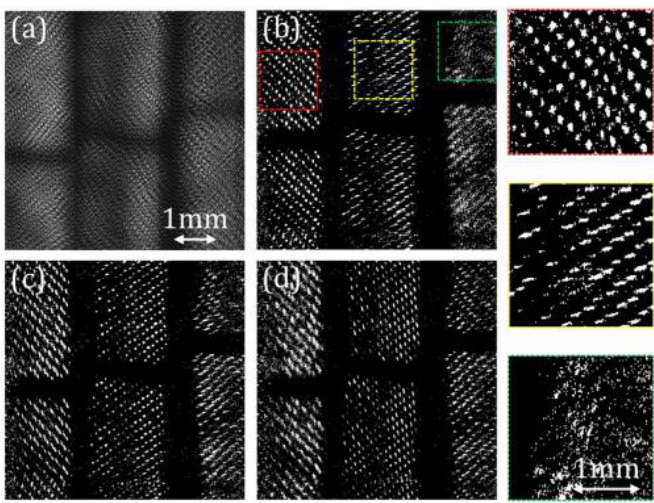
Figure 25. Experiment results. ( a ) Image obtained by directly scanning. ( b ) Image after filtering with a DL of 48.5 mm. The three insets on the right are the magnified images that correspond to the rectangular regions labeled in the image. ( c ) Image after filtering with a DL of 53.5 mm. ( d ) Image after filtering with a DL of 58.5 mm. (Figure reproduced from Ref. [96]).